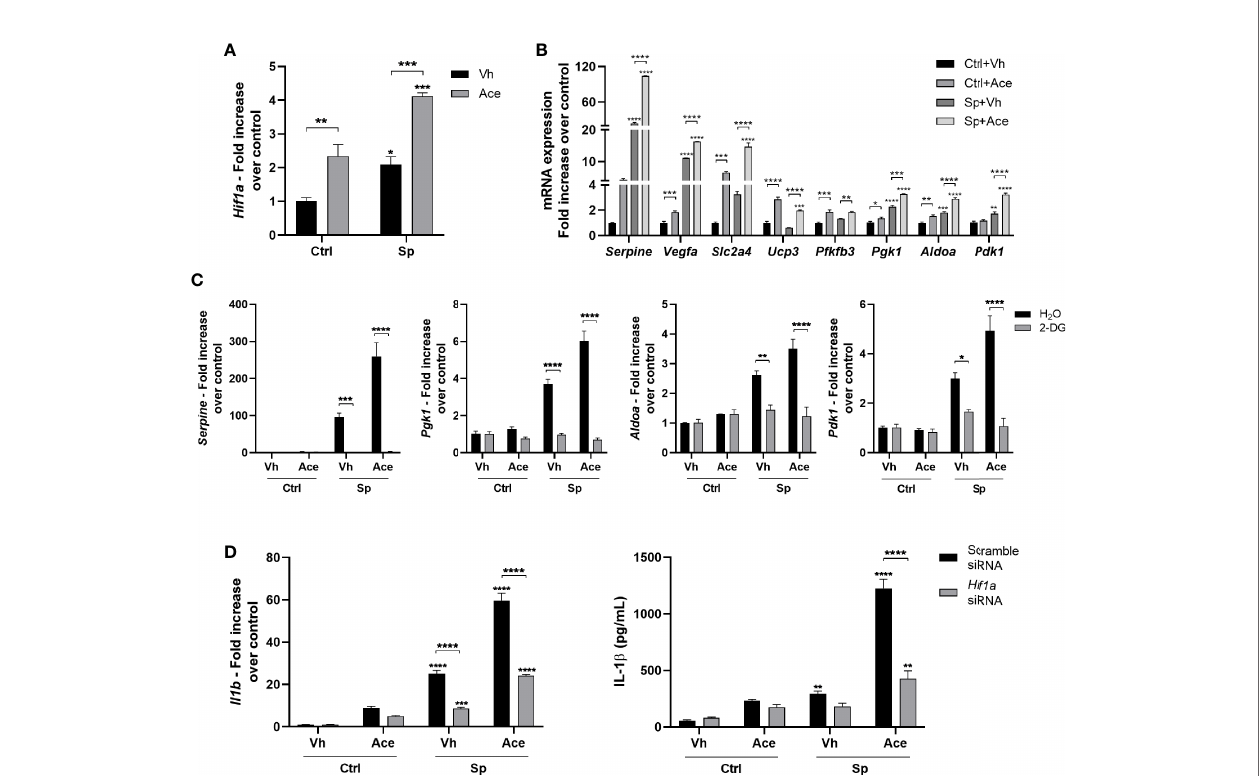
FIGURE 6 | Acetate increases HIF-1 a activity, via glycolysis, which increases IL-1 b production. (A) Fold increase of Hif1a mRNA assessed by RT-PCR from MPI cells pre-treated or not with acetate and stimulated or not with S. pneumoniae for 18 h. Fold increase was calculated over control (Ctrl+Vh). (B) Fold increase from mRNA of HIF1- a target genes: plasminogen activator inhibitor 1 ( Serpine ), vascular endothelial growth factor A ( Vegfa ), Solute carrier family 2, facilitated glucose transporter member 4 ( Slc2a4 ), mitochondrial uncoupling protein 3 ( Ucp3 ), 6-phosphofructo-2-kinase ( Pfkfb3 ), phosphoglycerate kinase 1 ( Pgk1 ), fructose- bisphosphate aldolase ( Aldoa ), 3-phosphoinositide-dependent protein kinase 1 ( Pdk1 ). Quantitative RT-PCR from MPI cells pre-treated or not with acetate and stimulated or not with S. pneumoniae for 18 h. Fold increase was calculated over each control (Ctrl+Vh). (C) Fold increase of Serpine , Pgk1 , Aldoa , Pdk1 mRNA assessed by quantitative RT-PCR from MPI cells treated or not with 2-DG and/or acetate in the presence or absence of S. pneumoniae for 18 h. Fold increase was calculated over control. (D) Fold increase of Il1b mRNA assessed by quantitative RT-PCR and ELISA for IL-1 b from MPI cells transfected with Hif1a siRNA or Scramble siRNA, treated or not with acetate in the presence or absence of S. pneumoniae for 18 h. Fold increase was calculated over each control (Ctrl+Vh). Bars showing the mean and error showing the SEM of triplicates. Results are representative of three independent experiments. Statistical analysis was done using Two- way ANOVA corrected with Sidak ’ s multiple comparisons test (*p < 0.05, **p < 0.01, ***p < 0.001, ****p <